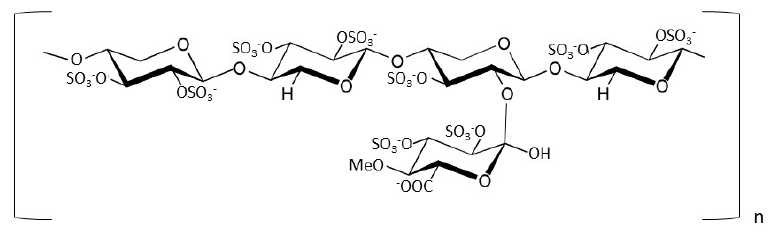
Figure 1. Molecular structure of pentosan polysulfate (PPS).